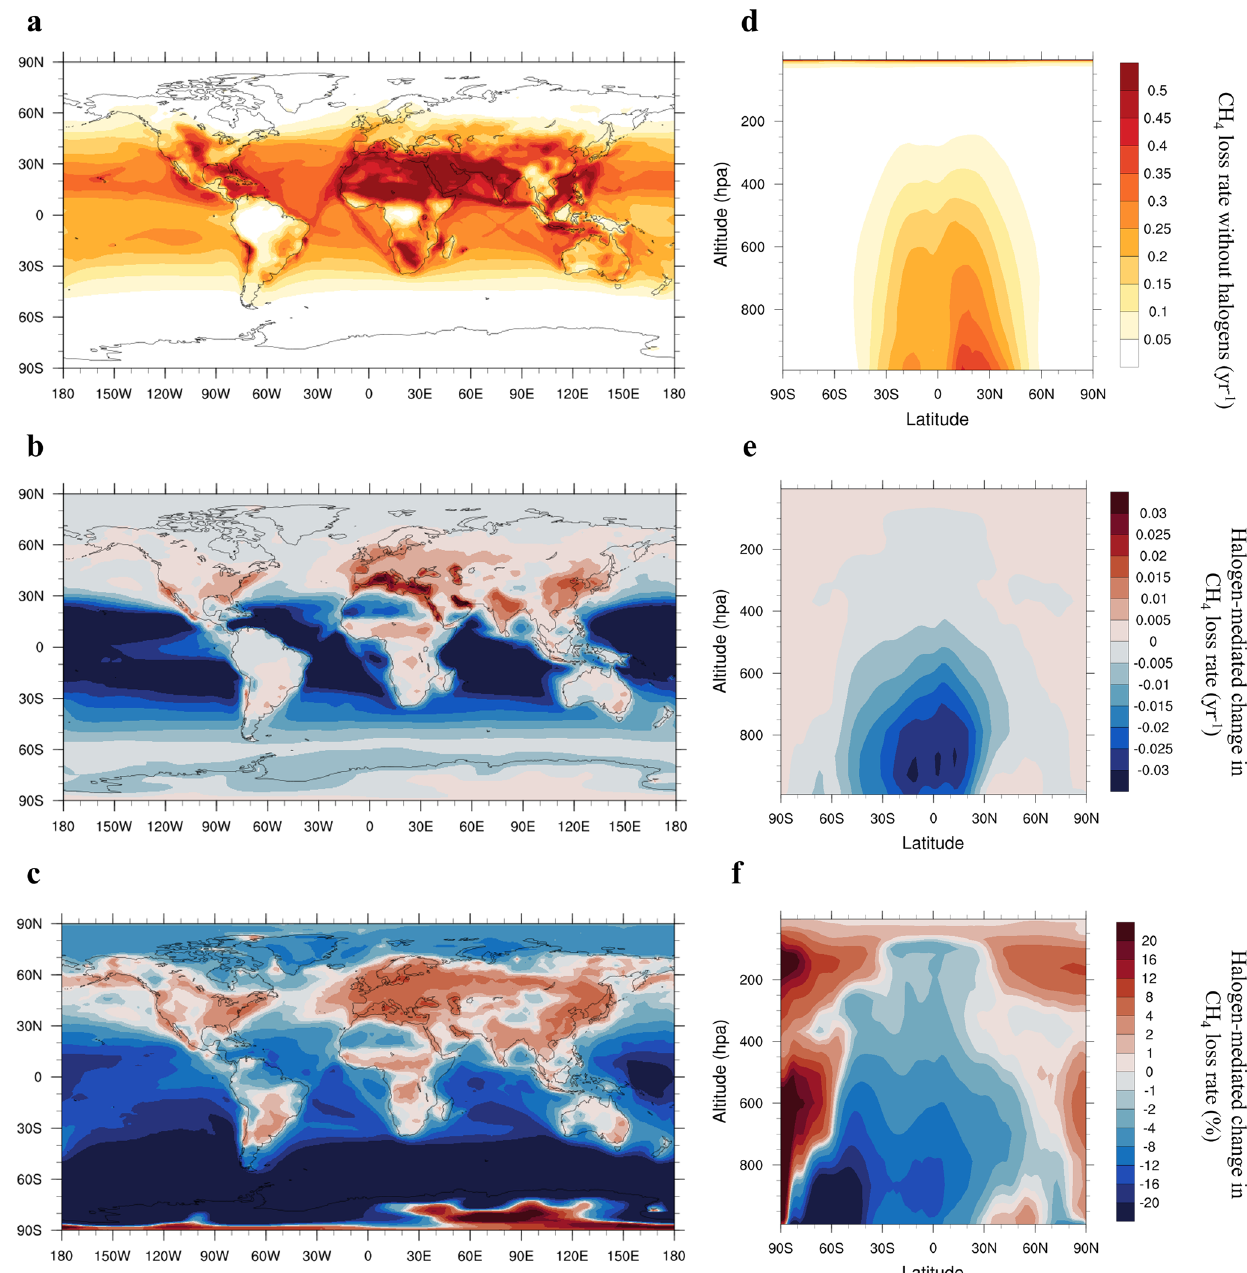
Fig. 2 Spatial patterns of halogen-mediated change in CH 4 loss rate averaged during the 21st century for RCP6.0 scenario. a Surface CH 4 loss (yr − 1 ) without halogens (noHAL). b Halogen-mediated changes in CH 4 loss (yr − 1 ) at the surface. c Same as ( b ) but in percentage. d Zonal distribution of CH 4 loss (yr − 1 ) without halogens (noHAL) showing the largest CH 4 loss near-surface level in tropics. e Zonal distribution of halogen-mediated change in CH 4 loss (yr − 1 ). f Same as ( e ) but in percentage. Results for the RCP8.5 scenario are shown in Supplementary Fig.